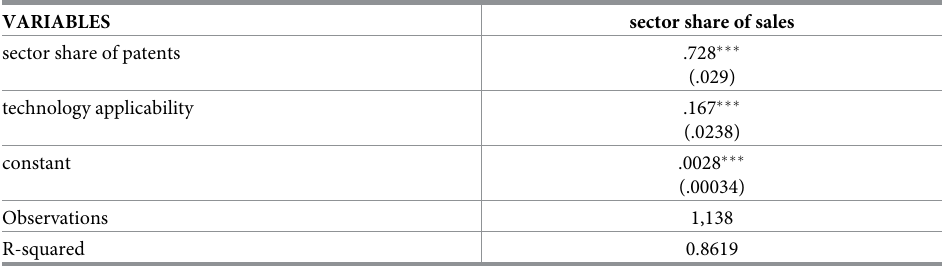
Table 3. Industry level market share of patents and